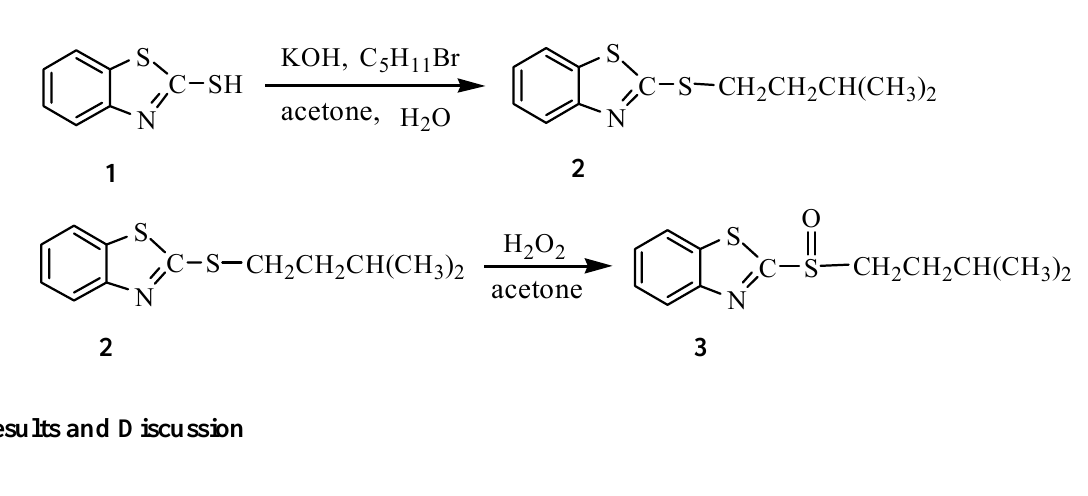
Figure 1 . The synthetic route of iso-amyl benzothiazolyl